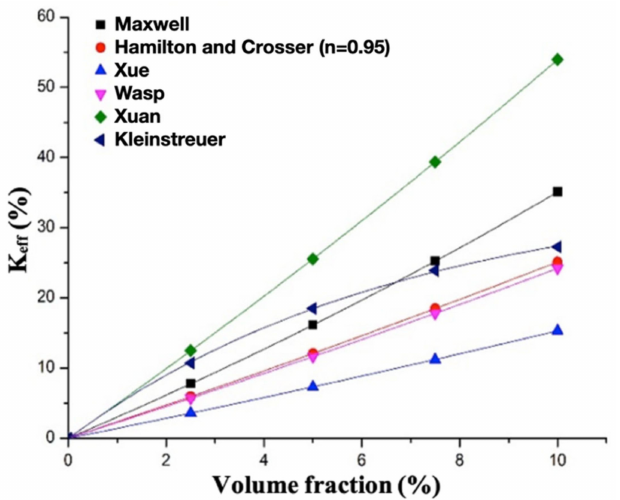
Figure 5. Behavior of the different models for thermal conductivity prediction of an NF in function of the nanoparticle(NP) fraction